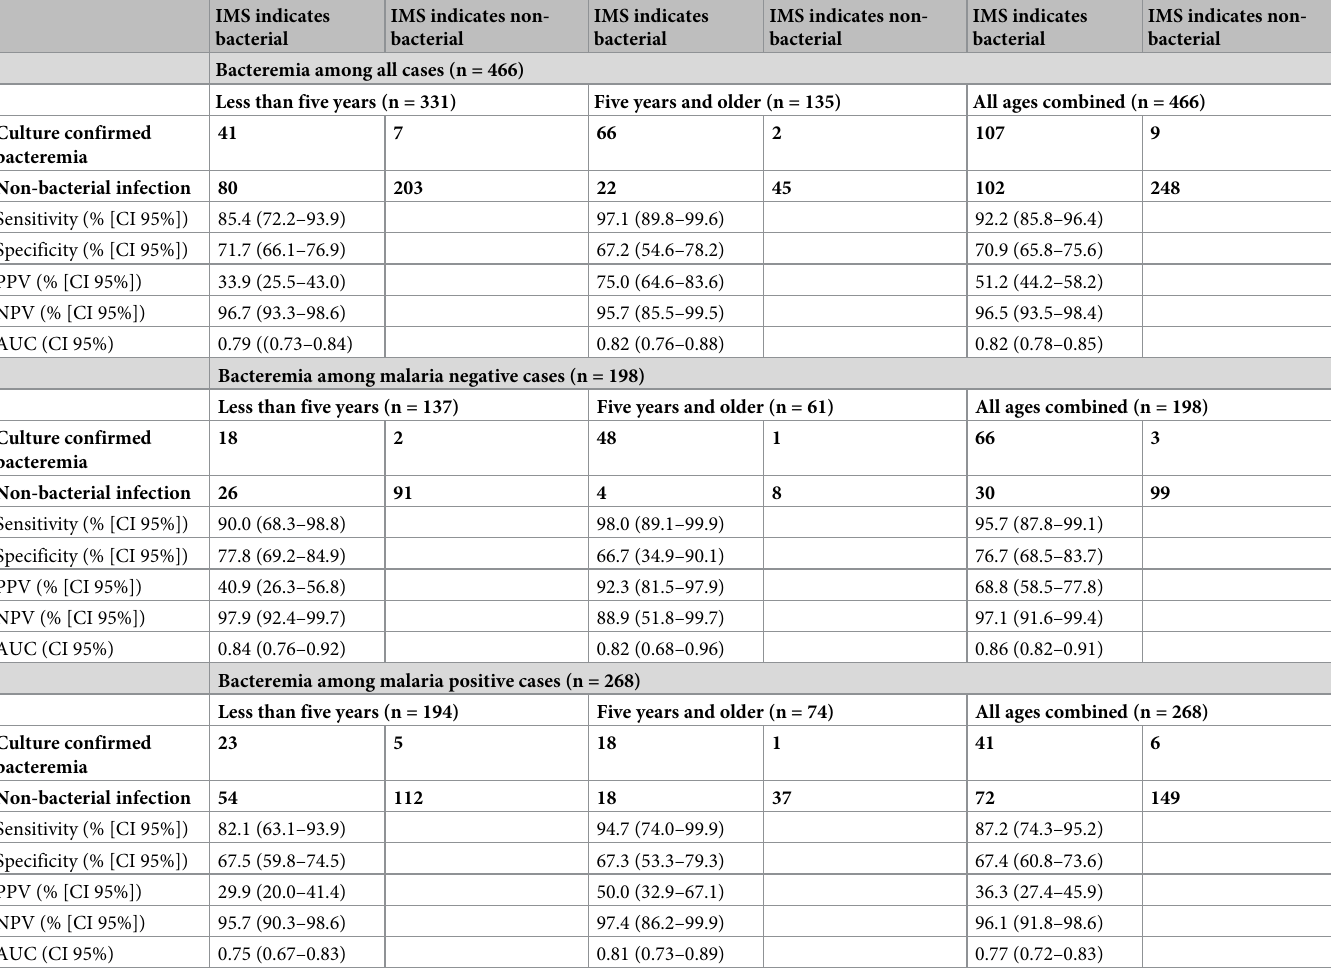
Table 3. Diagnostic accuracy of the IMS for bacterial bloodstream infections presented by age group for patients with- and without malaria parasitemia (qPCR > 0.05 p/uL). The reference value is presented on the rows, the IMS result is presented in the columns. IMS indicates